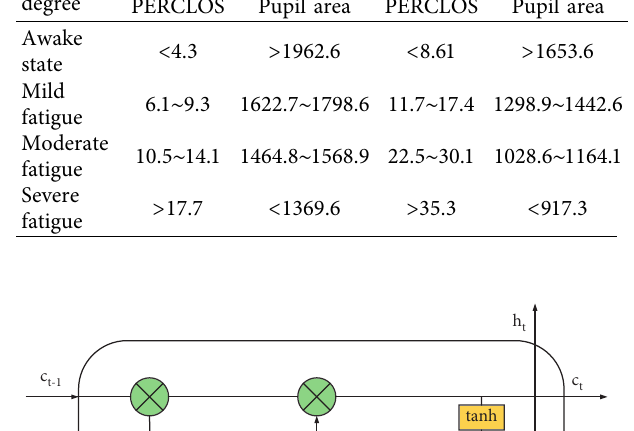
Figure 9: Driver’s mean